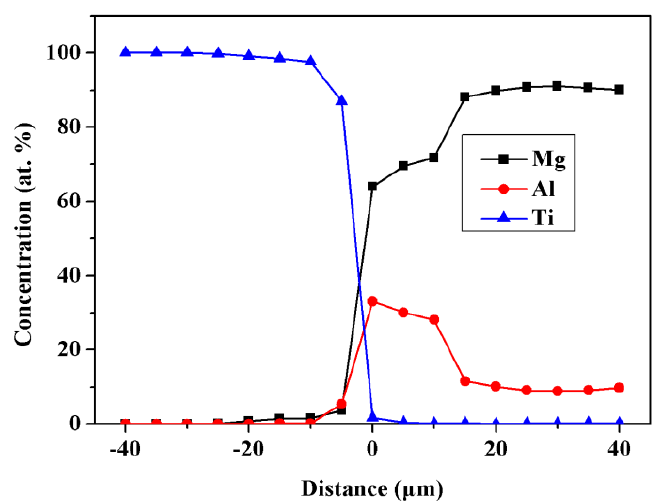
Figure 6. Concentration profiles of the interface between Mg-9Al matrix and Ti rod annealed after 60 min at 700 °C.